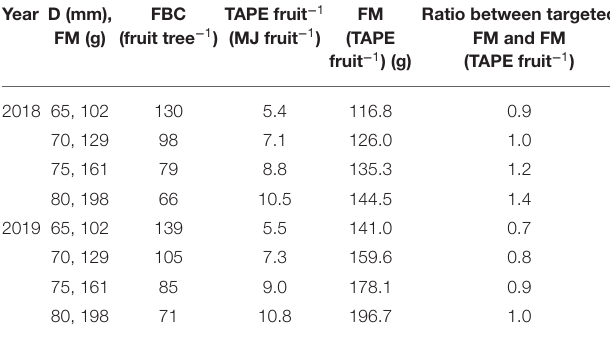
TABLE 4 | FBC considering the four target fruit diameters (D) converted into fresh mass (FM) of ‘Gala’/M.9 apple trees in 2018 and 2019 of trees with a mean of 5.5 m ² total LA; the total absorbed photosynthetic energy (TAPE) (MJ fruit − 1 ) per fruit considering the FBC; the measured FM receiving this TAPE per fruit, the ratio between the targeted fruit FM and measured FM.